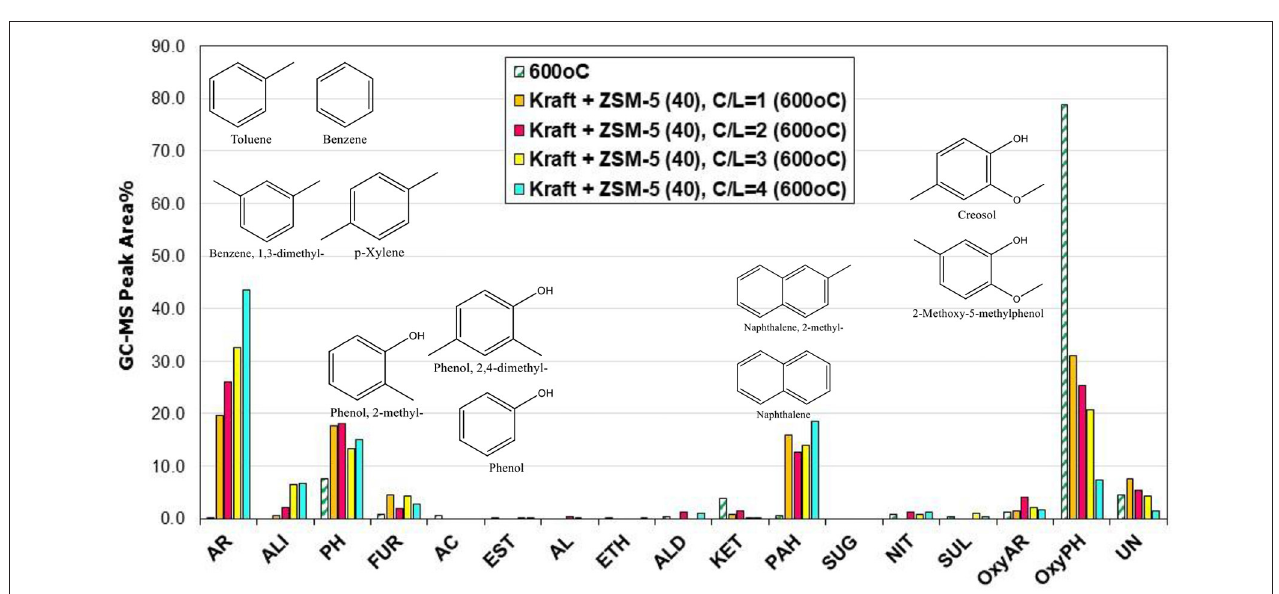
acid sites, in combination with the specific micropore framework structure of each zeolite type, have a pronounced effect on the reactions that occur during the pyrolysis process and the final product yields and bio-oil composition. For this reason,